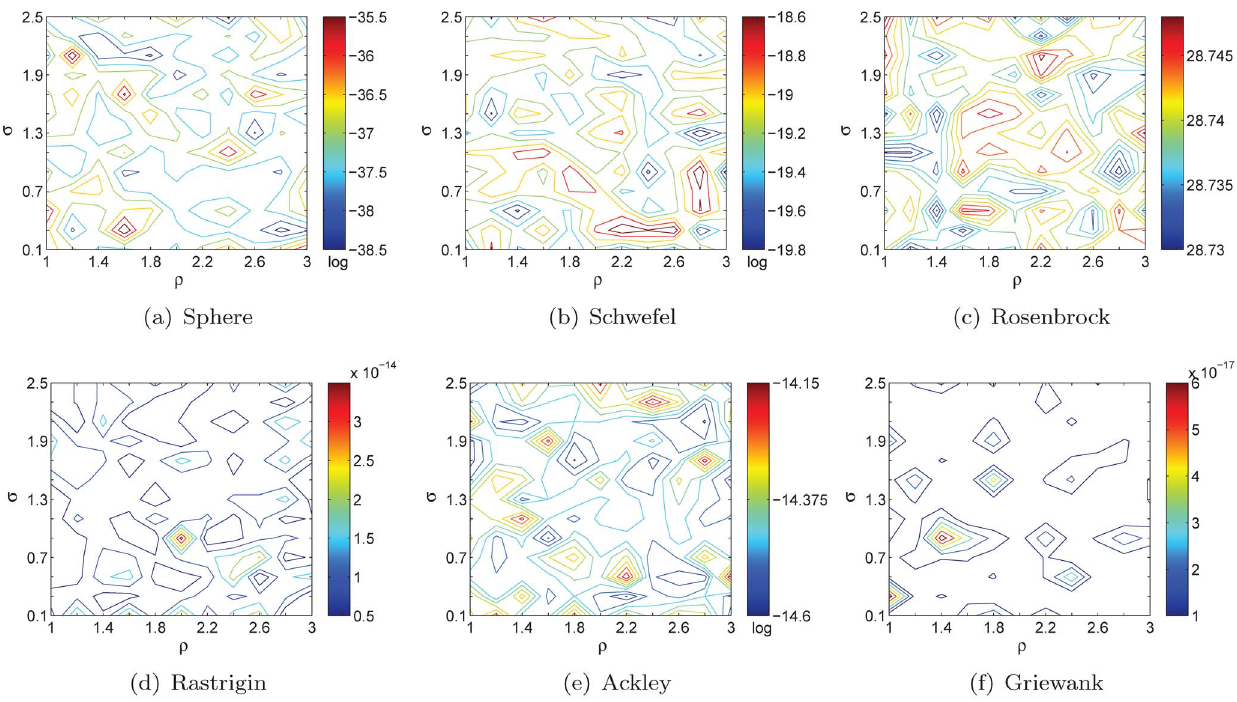
Figure 2. The relationship between the two factors ( s and r ) and the performance of AdaFa.